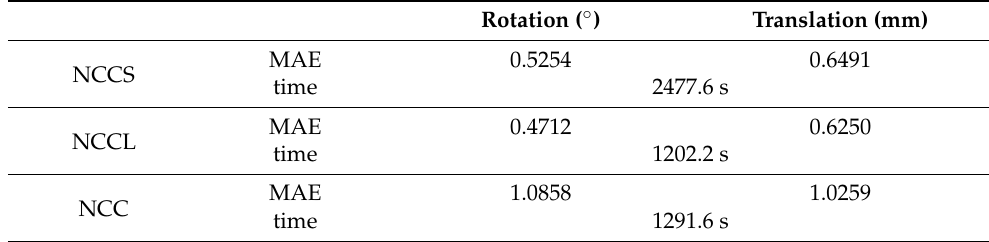
Table 4. Data table of multiresolution experiment results.